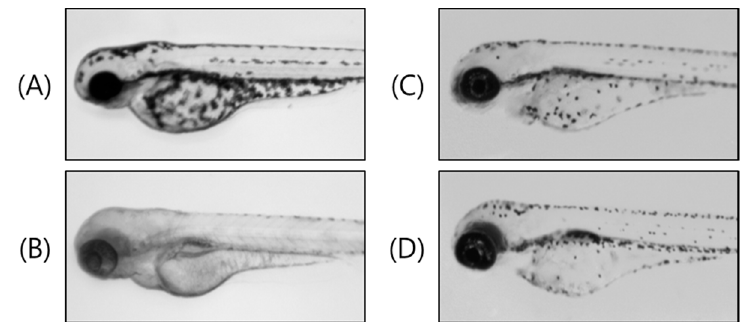
Figure 4. Effects of compound 1 on melanogenesis in zebrafish. Synchronized embryos were treated with melanogenic inhibitors at the indicated concentrations. Compound 1 was dissolved in 0.1% DMSO and then added to the embryo medium. The effects on pigmentation of zebrafish were observed under the stereomicroscope: ( A ) (vehicle control) untreated zebrafish embryo; ( B ) (positive control) 100 µM 1-phenyl-2-thiourea (PTU); ( C ) 40 µM compound 1 ; and ( D ) 80 µM compound 1 .